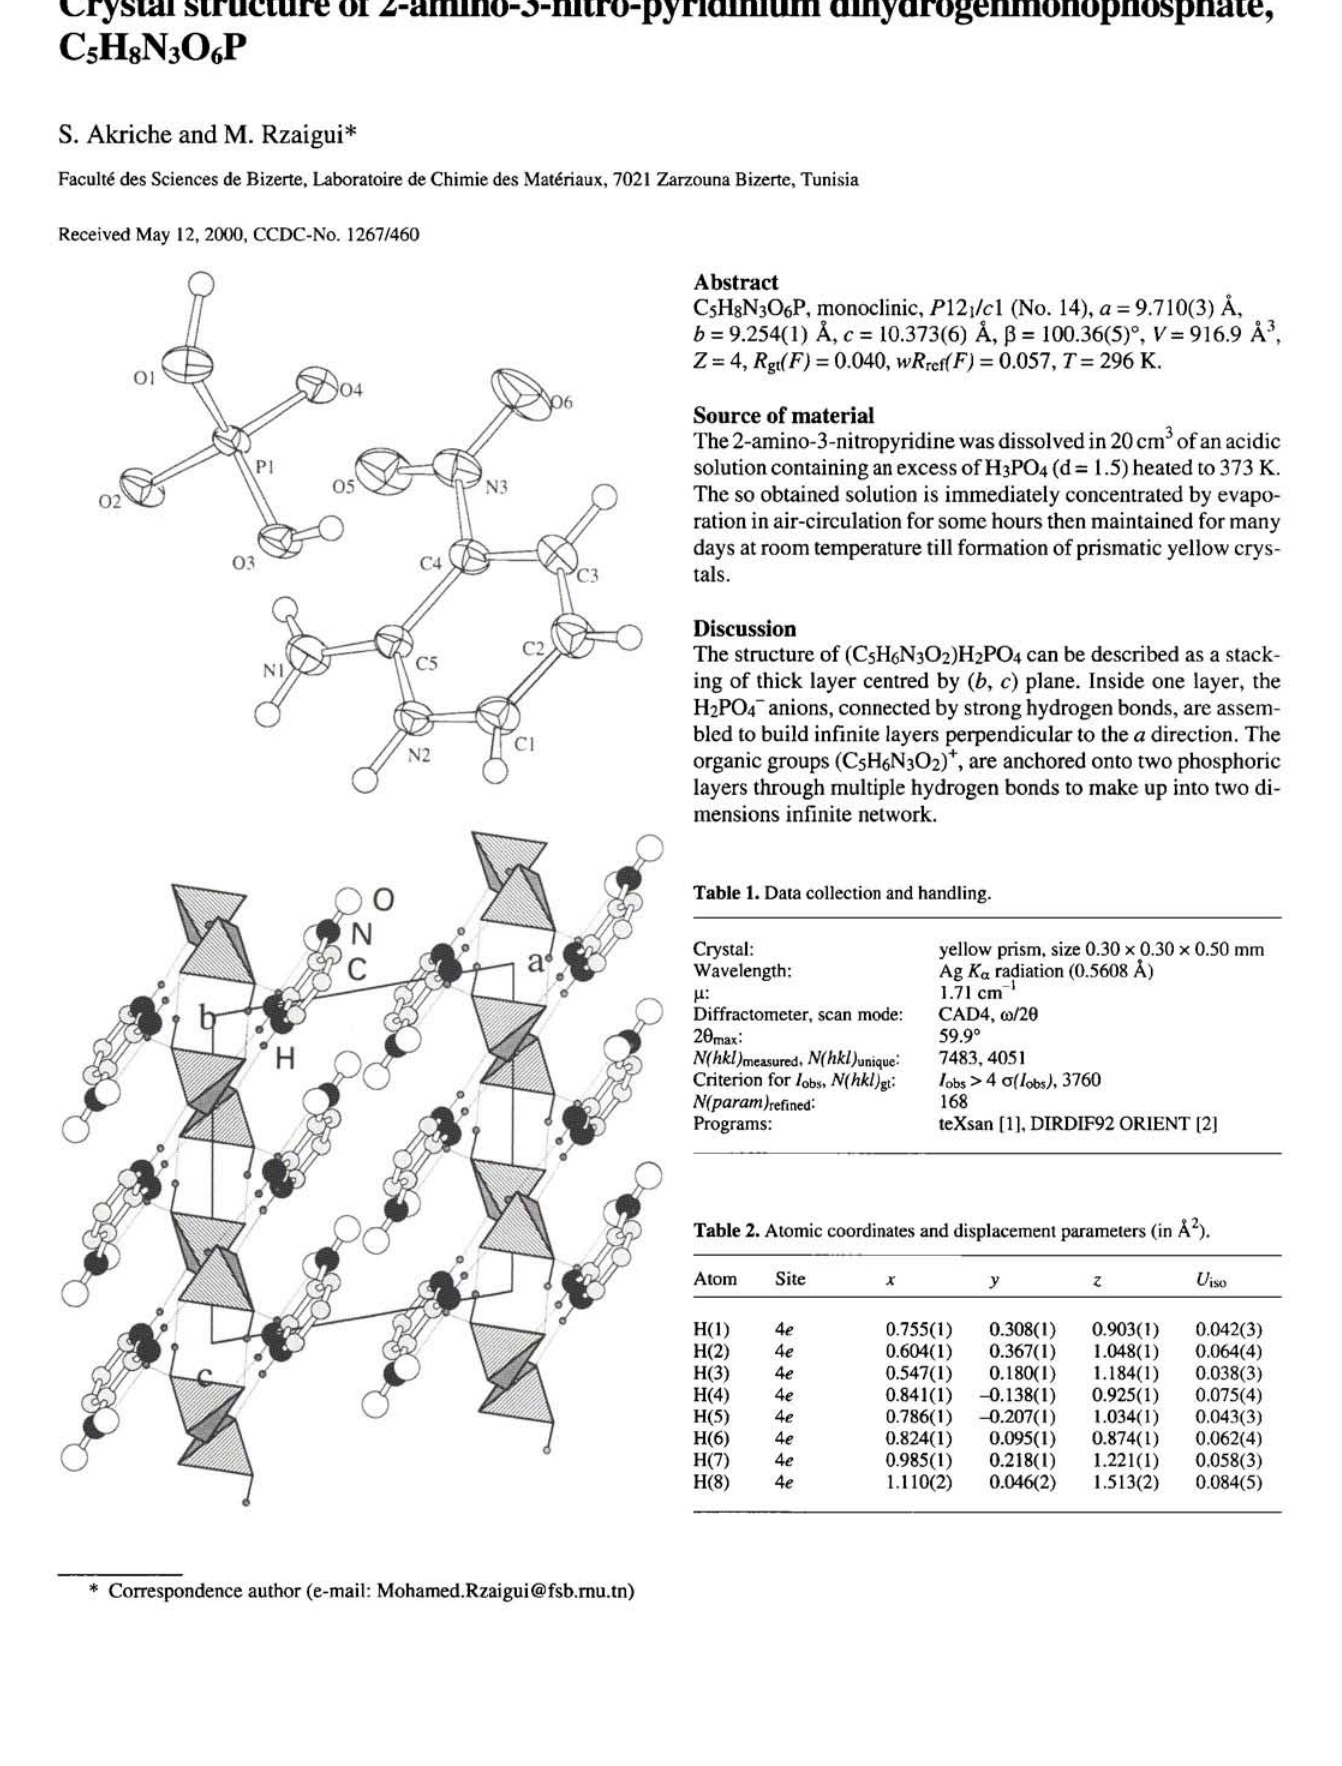
Table 1. Data collection and handling. Crystal: Wavelength: Diffractometer, scan mode: 20max: